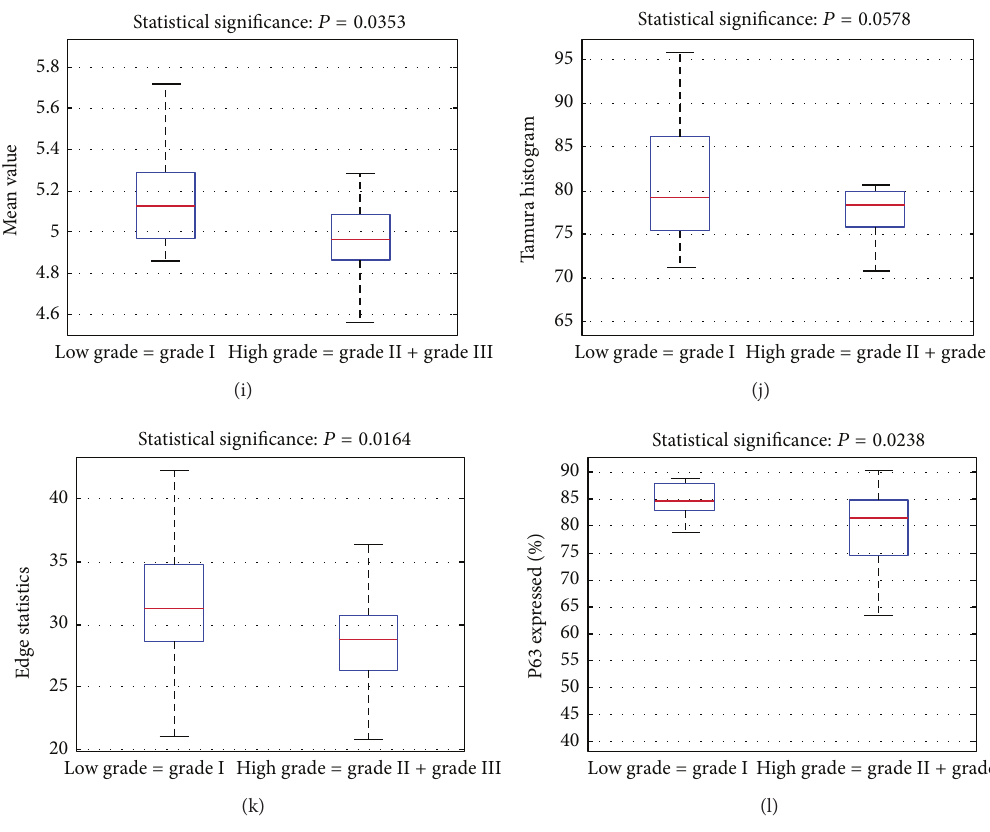
Figure 3: Box plots of features sustaining statistically significant differences between low and high grade classes. (a) Run length emphasis, (b) run percentage, (c) contrast, (d) inverse difference moment, (e) difference variance, (f) difference entropy, (g) run length nonuniformity, (h) solidity, (i) mean value, (j) Tamura histogram feature, (k) edge statistics feature, and (l) percentage of positively expressed nuclei.